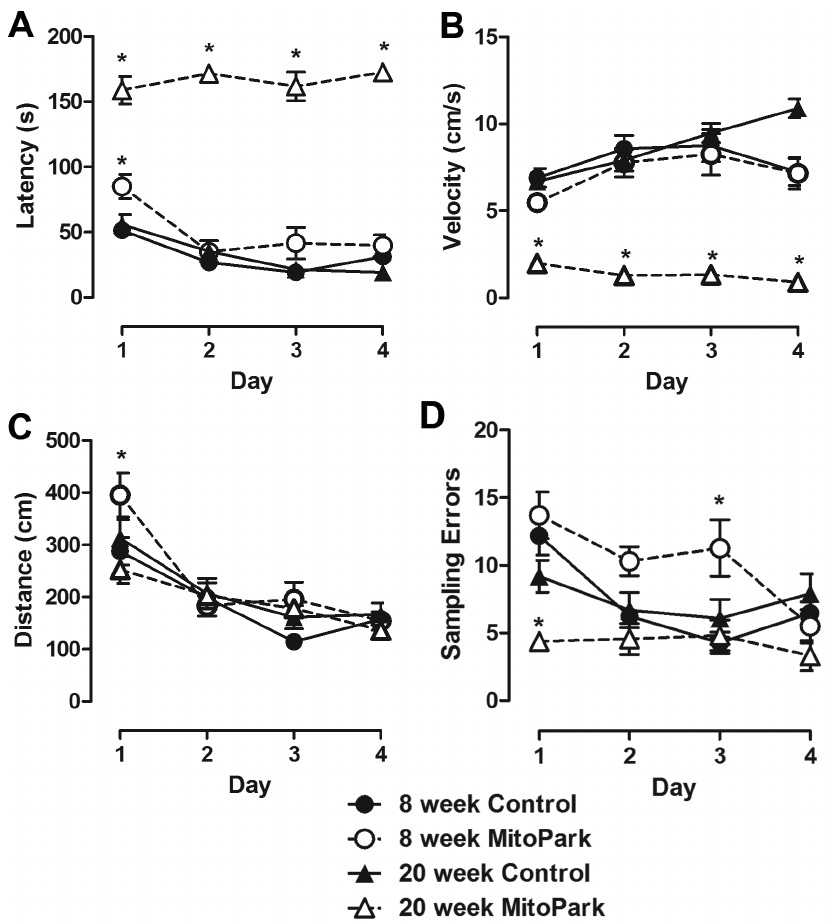
Figure 2. Profound motor impairment prohibits assessment of spatial learning in mature MitoPark mice. Spatial learning was assessed before (8 week old) or after (20 week old) the development of motor impairment in MitoPark mice or their age matched wild-type littermate controls. (A) Latency to locate the target hole, (B) velocity during the test, (C) distance traveled to locate the target hole and (D) the number of sampling errors on each of four successive training days was measured. Data represent the mean 6 SEM of the daily averages for each mouse, (n=8 mice/group). Significant post hoc effect indicated (*p , 0.05) for MitoPark versus same age and day controls.